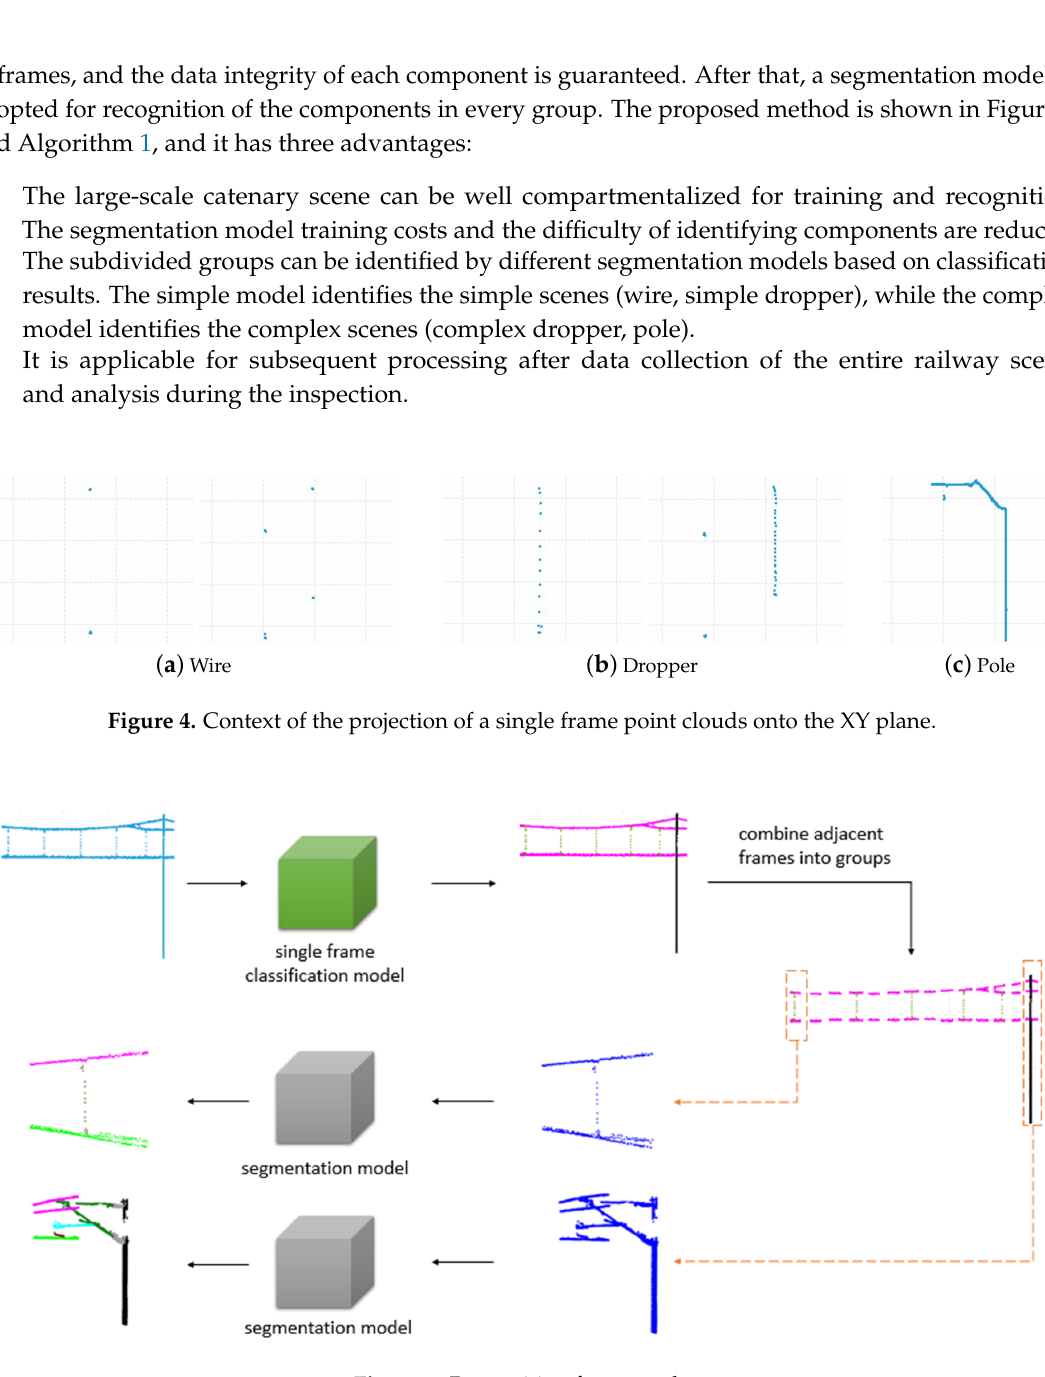
Figure 5. Recognition